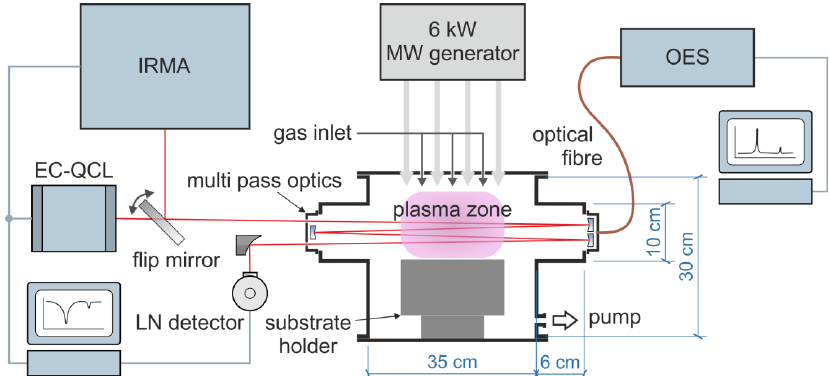
Figure 33. Experimental arrangement of the distributed antenna array (DAA) microwave reactor combined with the AS spectrometer consisting of the IRMA system and an external cavity QCL (EC-QCL) and the OES unit [66], © IOP Publishing. Reproduced with permission. All rights reserved.